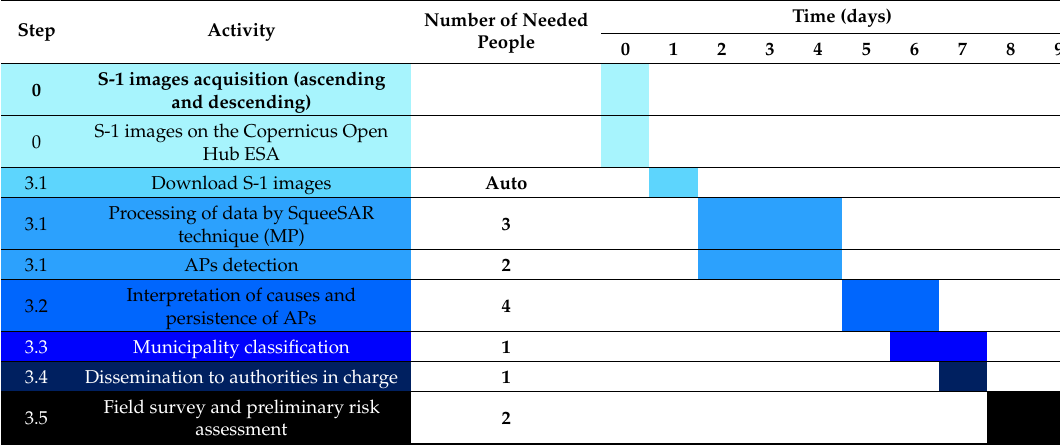
Table 5. Timesheet for the proposed procedure.